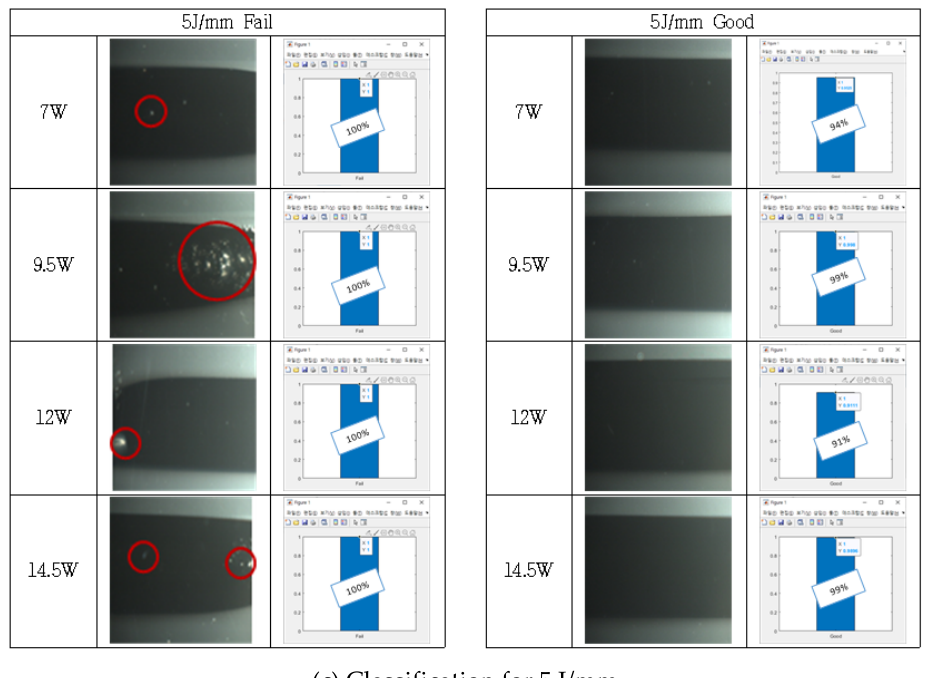
( c ) Classification for 5 J/mm. Figure 9. Quality evaluation by deep learning. Figure 9. Quality evaluation by deep learning.